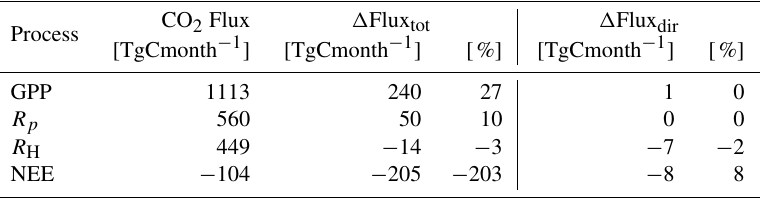
Figure 16. Mean net CO 2 fluxes (µmolCm − 2 s − 1 ) weighted per biome type for September 2010 at 16:00UTC (column a ). The differences in the mean CO 2 fluxes as simulated in DIR+DIF and NO-AER (column b ) and in DIR-AER and NO-AER (column c ) during the same time period. The first to the fourth rows indicate the results for GPP, R P , R H , and NEE processes, respectively. The darker black contour line on the maps delimits the LBAR. Table 4. Total CO 2 assimilation ratio for the DIR+DIF simulation, (cid:49) Flux tot , and (cid:49) Flux dir in the LBAR during September 2010 for the different atmosphere–biosphere exchange